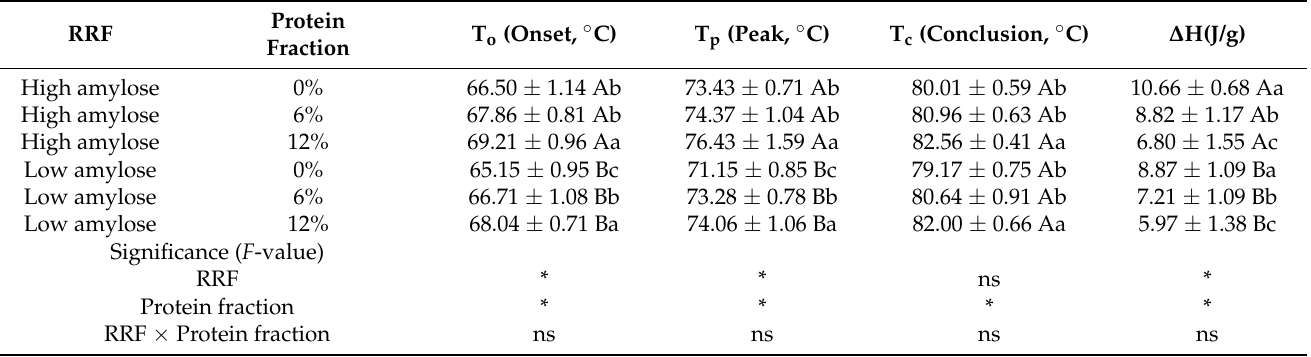
Table 2. The thermal properties of reconstituted rice flour (RRF) with different AC and protein fractions